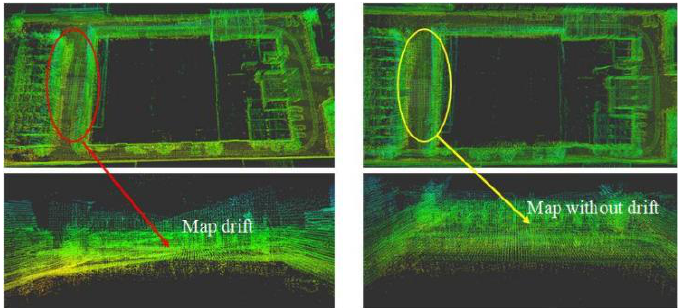
Figure 12. The map drift in small scale scenario is eliminated by back-end optimization. The figure on the left is unoptimized, and the right one is optimized. It can be seen that the map drift of the optimized map is significantly reduced.